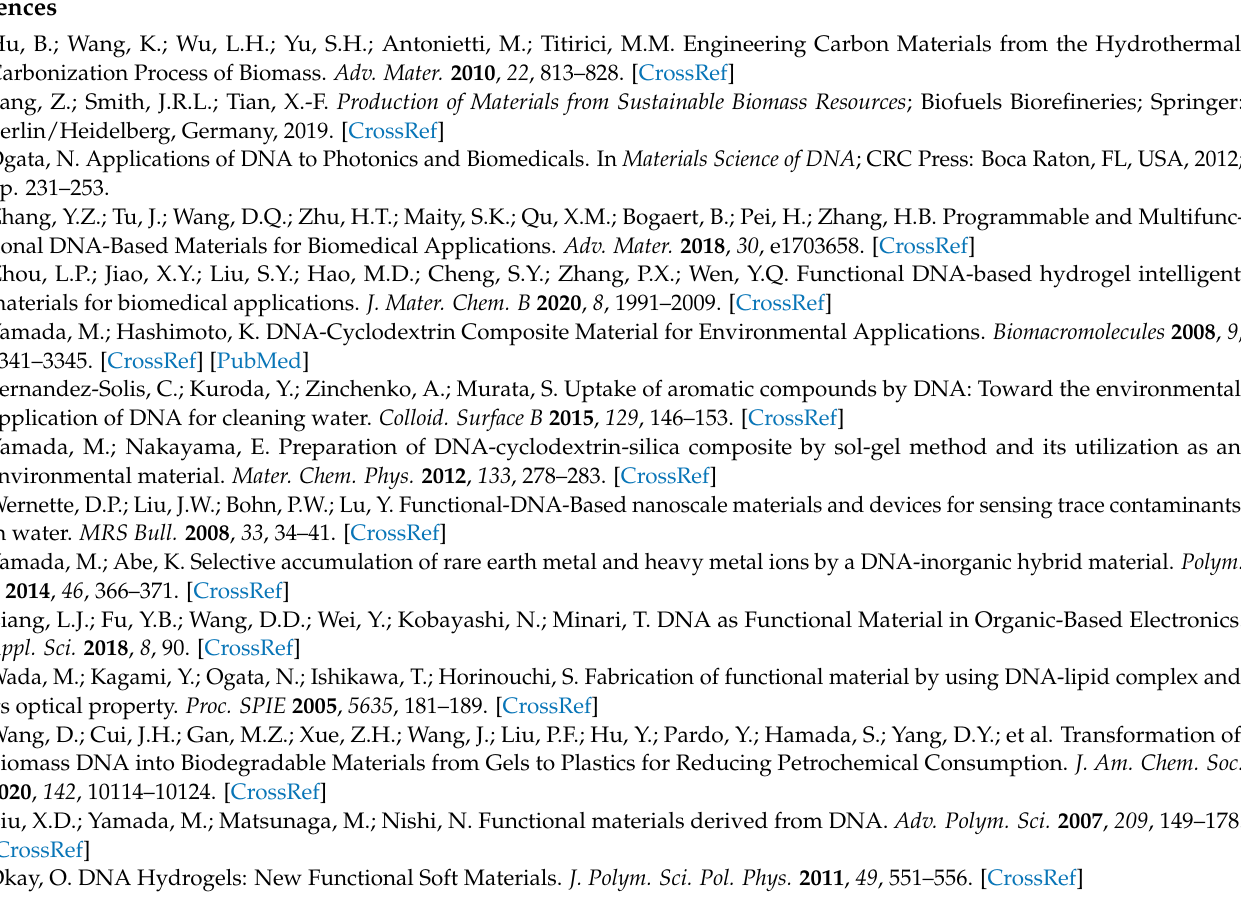
Figure S2 NMR spectra of AMP biodots; Figure S3: FTIR spectra of AMP and AMP biodots; Figure S4: Fluorescent properties of HT treatment product of ribose; Figure S5: Comparison of fluorescent dialysis; Figure S7: Fluorescent properties of biodots after dialysis, Figure S8: Comparison of